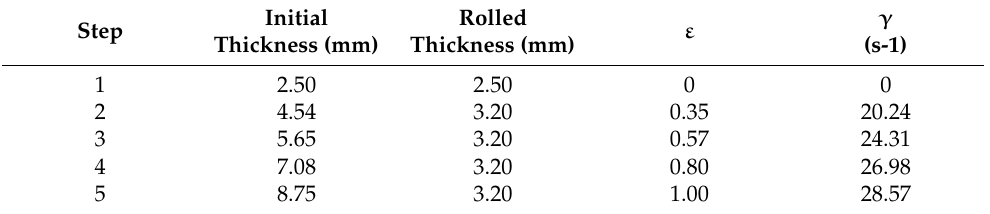
Table 1. Strains and strain rates applied to the stepped R1 and R2 samples in the hot rolling